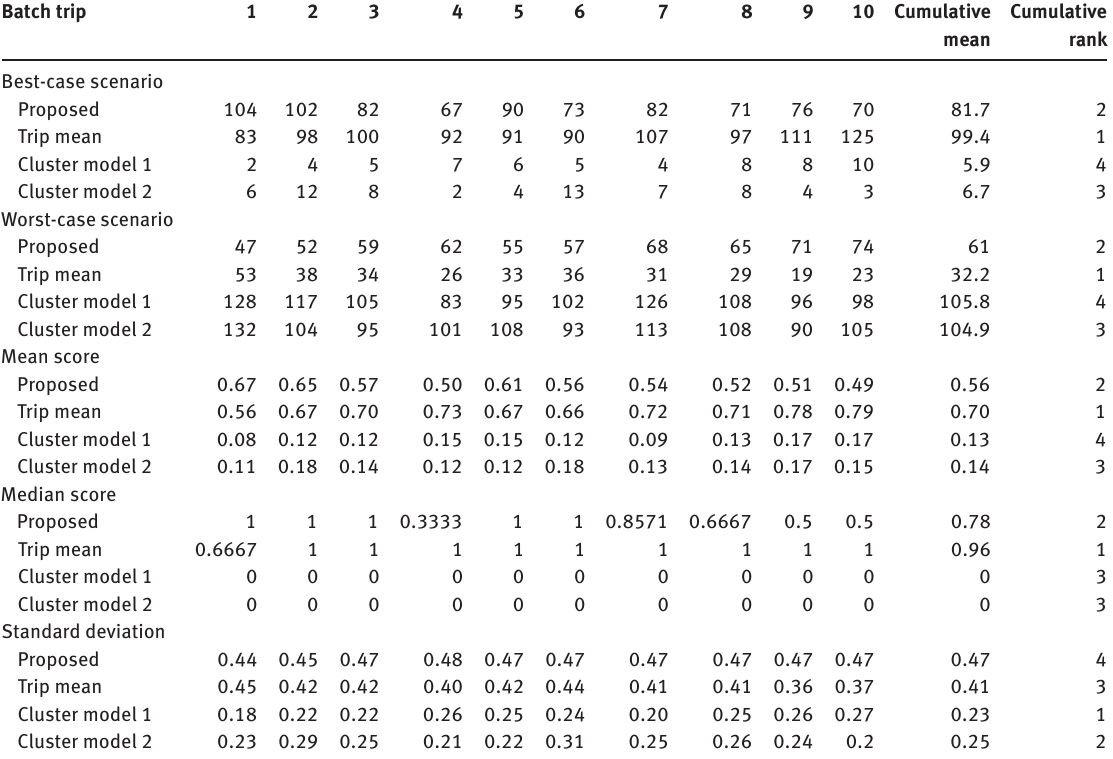
Table 2: Statistical Report on Trip Planning Models for Zero